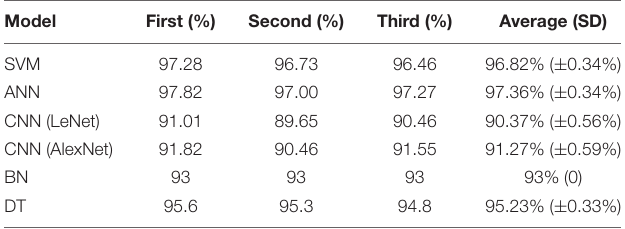
TABLE 3 | Accuracy results of each model.